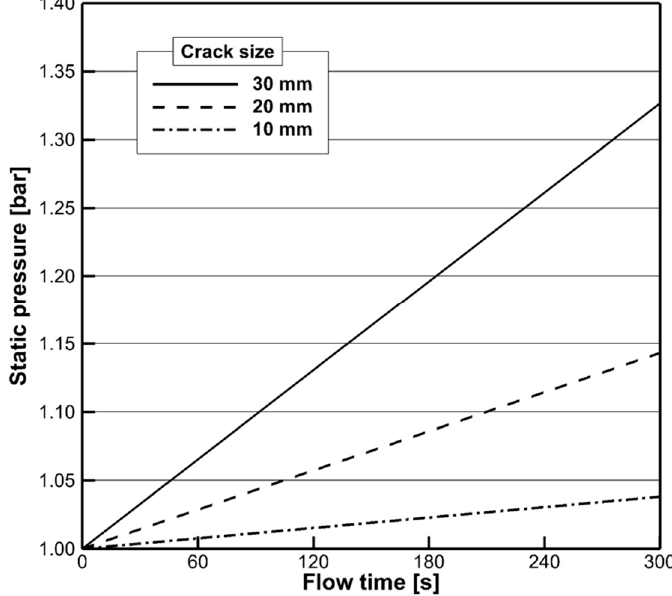
Figure 6. Volume-averaged static pressure evolution with time at different crack sizes.